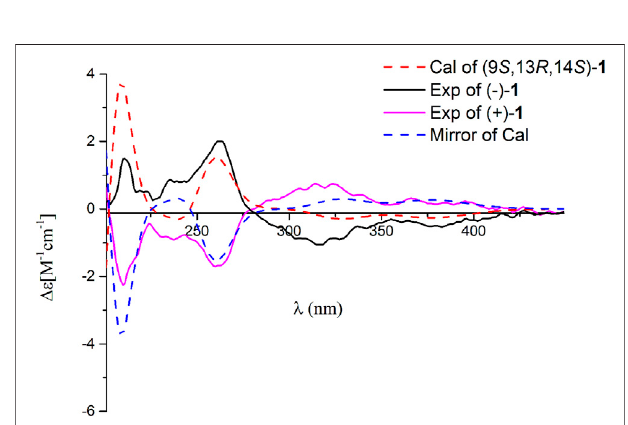
FIGURE 3 | Comparison of the calculated ECD spectrum of 1 at the PBE1PBE/def2SVP level with the experimental one in MeOH. σ (cid:1) 0.25 eV; shift (cid:1) 13 nm.